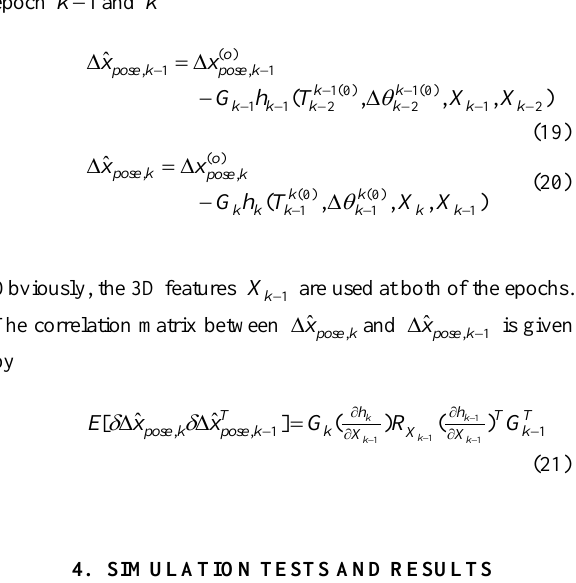
0.10m. The 2D visual odometry measurements were computed deviations and number of the used